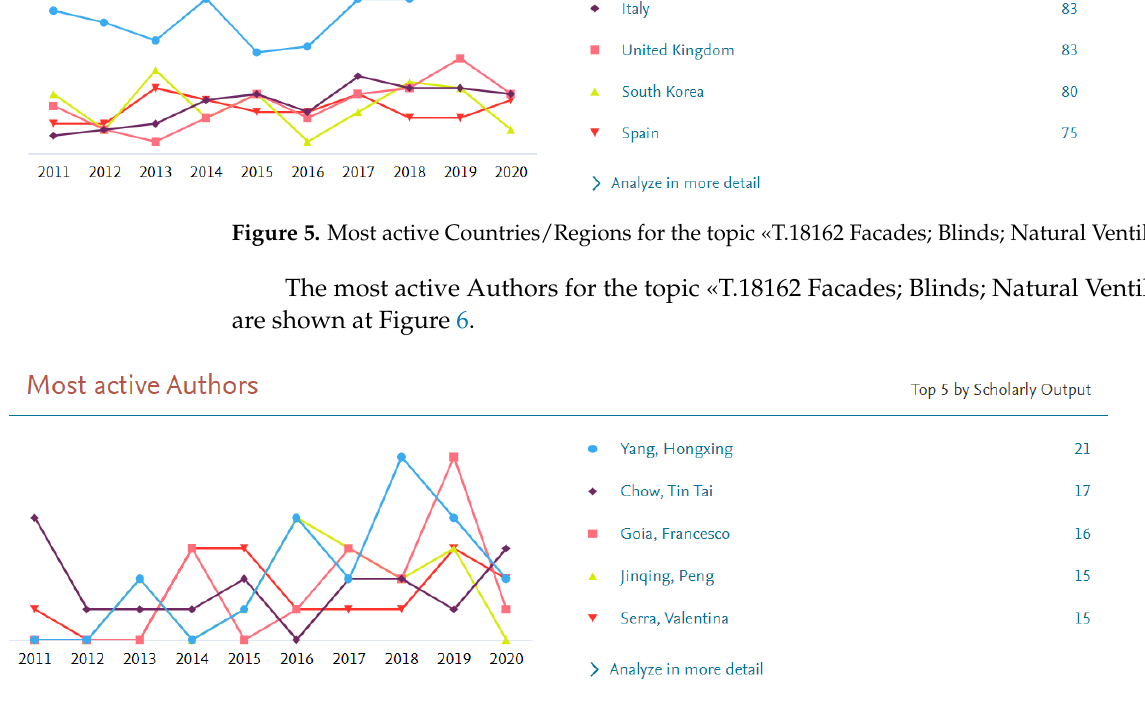
Figure 6. Most active Authors for the topic «T.18162 Facades; Blinds; Natural Ventilation». The most active Authors for the topic «T.18162 Facades; Blinds; Natural Ventilation» are shown at Figure 7.